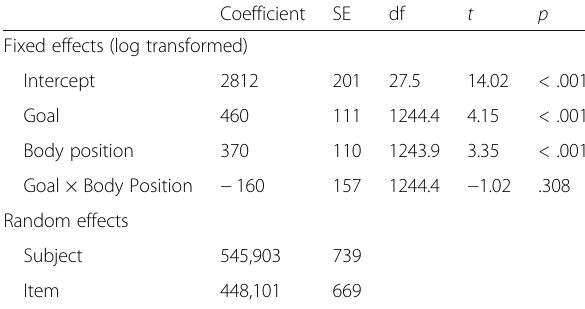
Table 2 Model estimates for linear mixed model predicting viewing time (experiment 1)